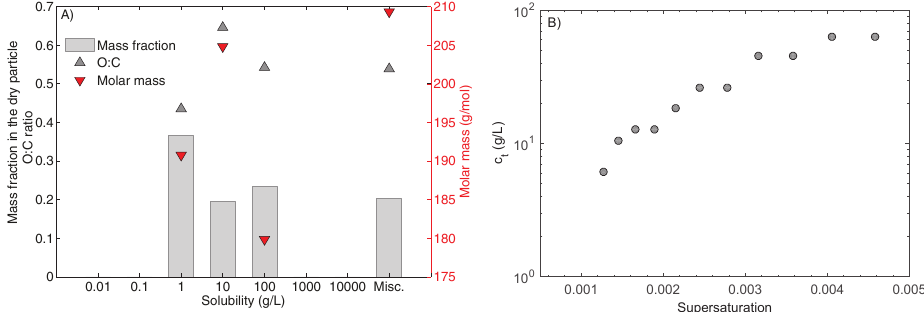
Figure 13. (a) An example of a solubility distribution for SOA generated in dark ozonolysis of α -pinene SOA. The expected composition has been taken from Chen et al. (2011), and the pure-component solubilities have been calculated with the SPARC prediction system (e.g., Wania et al., 2014, and references therein). “Misc.” refers to completely miscible components. (b) The dependence of the c t value at the point of activation on supersaturation assuming an ideal organic mixture, with only points corresponding to limited solubility (0< ε <1)